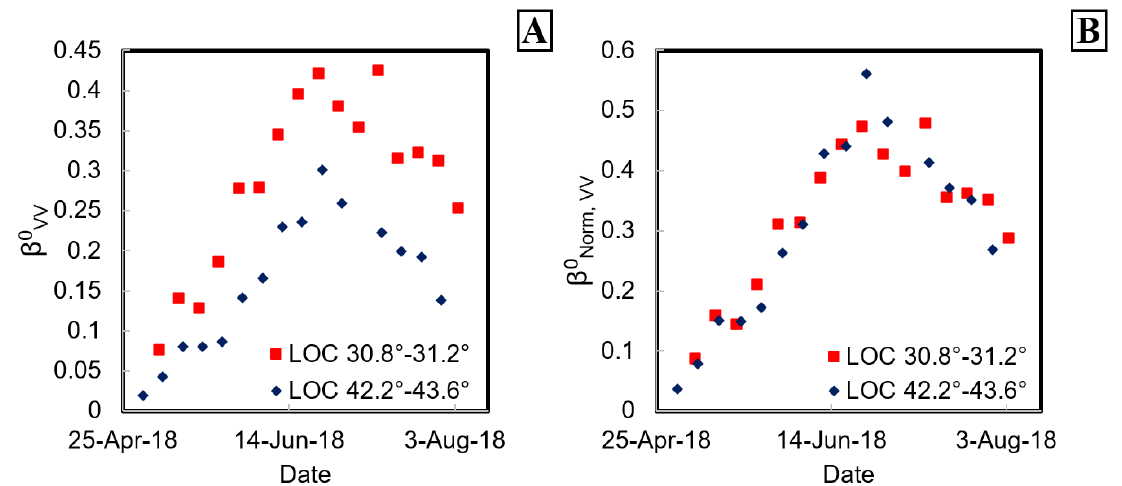
Figure 8. A time series of VV polarization values recorded by Sentinel-1 on its descending overpasses with local incidence angles in the ranges of 30.8°–31.2° and 42.2°–43.6° during the processing tomato experiment in Gadash, 2018: ( A ) prior to applying the β 0 normalization; ( B ) post-normalization.